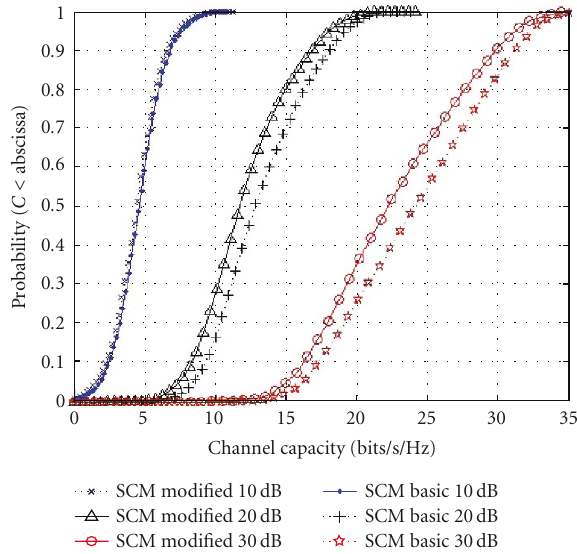
Figure 7: Simulated outage capacity; RMS = 15degrees Figure 8: Simulated outage capacity; RMS = 24degrees